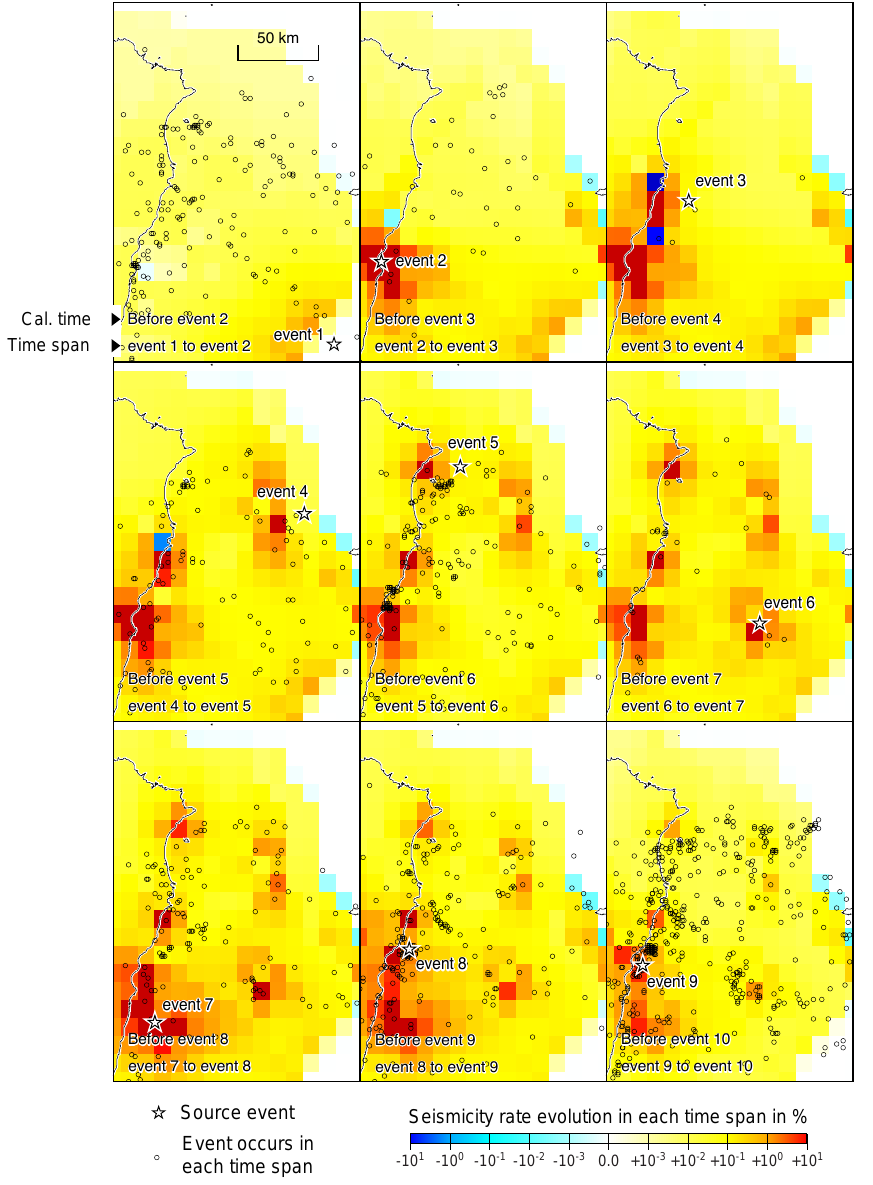
Figure 4. The seismicity rate evolution at different time moments. The (cid:49) CFS for each grid is defined as the maximum Coulomb stress changes for the entire seismogenic depth. Source parameters for the source events for calculating are shown in Table